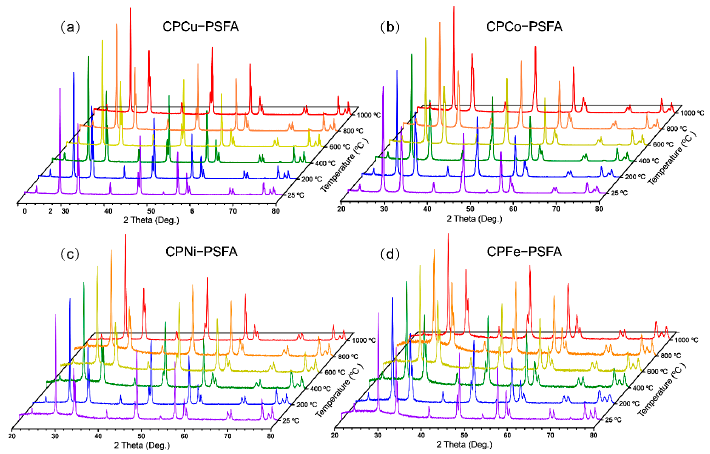
Figure 6. In-situ XRD patterns for ( a ) CPCu-PSFA and ( b ) CPCo-PSFA powders under CO 2 atmo- sphere in the temperature range of 25–1000 ◦ C; XRD patterns of ( c ) CPNi-PSFA and ( d ) CPFe-PSFA powders calcined at 25–1000 °C for 24 h under CO 2 atmosphere.